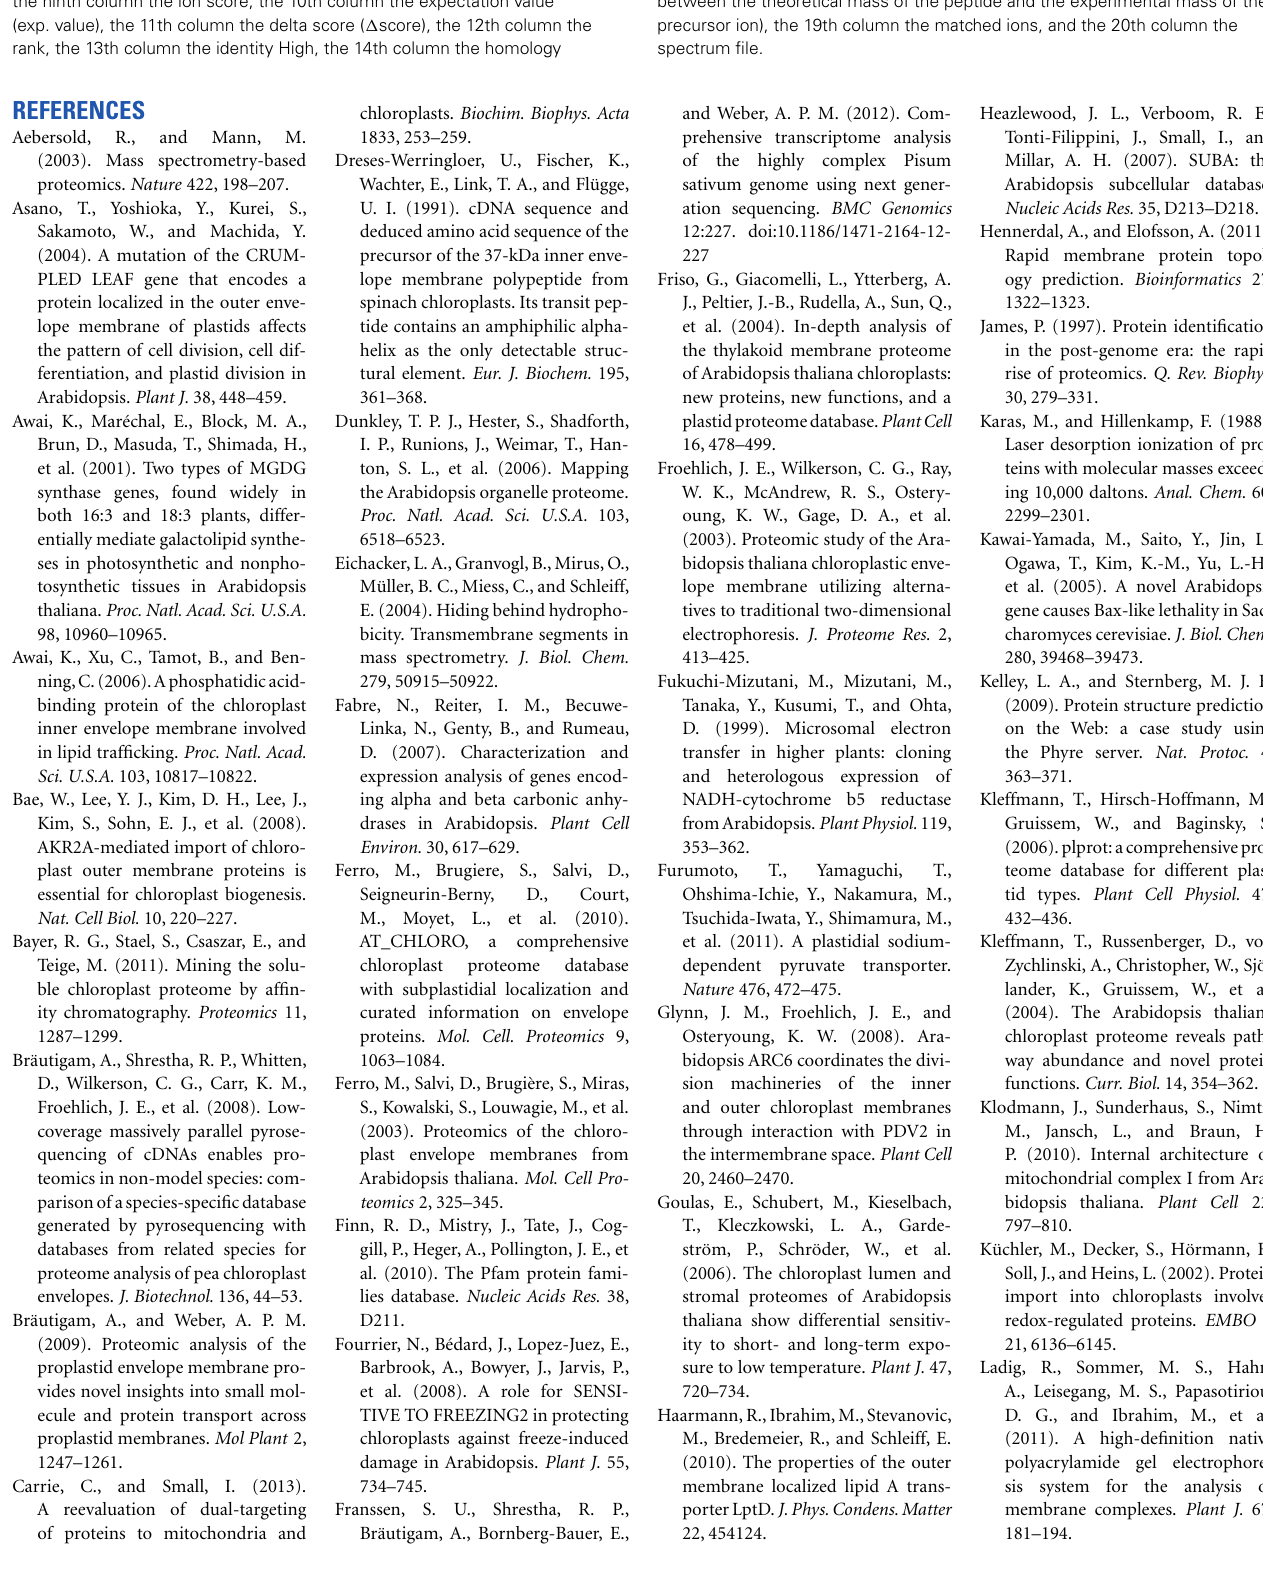
The chloroplast envelope proteome